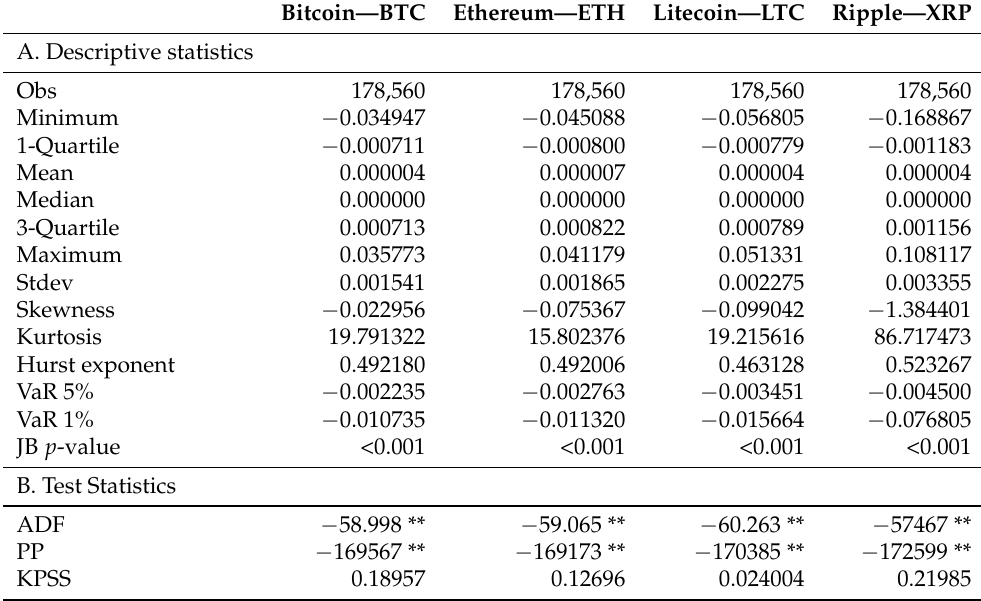
Table 2. Descriptive statistics and unit root tests of cryptocurrencies’ 1 min returns.